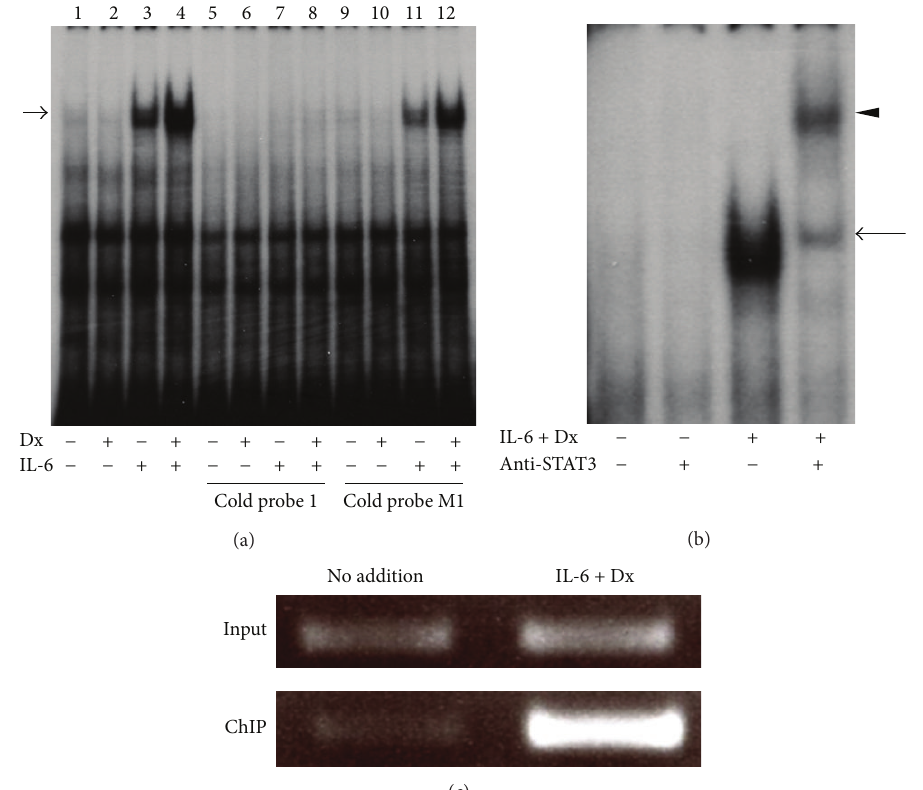
Figure 5: IL-6 + Dx-increased STAT3 binding to the REG I 𝛼 promoter. (a) Detection of DNA-protein complexes using EMSA. Nuclear extracts (2.5 𝜇 g protein) prepared from 1.1B4 cells, treated without or with Dx (100nM), or IL-6 (20ng/mL), or IL-6 + Dx, were incubated with a 32 P-labeled probe 1. Nuclear extracts from untreated cells were applied onto lanes 1, 5, and 9; those from Dx-treated cells were applied onto lanes 2, 6, and 10; those from IL-6-treated cells were applied onto lanes 3, 7, and 11; and those from IL-6 + Dx-treated cells were applied onto lanes 4, 8, and 12. Lanes 1–4 contain no competitor; lanes 5–8 contain 100 × unlabeled probe 1; lanes 9–12 contain 100 × unlabeled probe M1. An arrow marks IL-6 + Dx-inducible complex migration. (b) Supershift assay of STAT3 containing complex. EMSAs were performed in the presence or absence of STAT3 antibodies as indicated. An arrow marks IL-6 + Dx-inducible complex migration. An arrowhead indicates supershift complex by anti-STAT3 antibody. (c) ChIP assay showing IL-6 + Dx increases in STAT3 binding to the REG I 𝛼 promoter. 1.1B4 cells were treated without or with IL-6 (20ng/mL) + Dx (100 nM). ChIPs were performed with anti-STAT3 antibody, followed by PCR with primers specific for the REG I 𝛼 promoter. A representative result from three experiments is